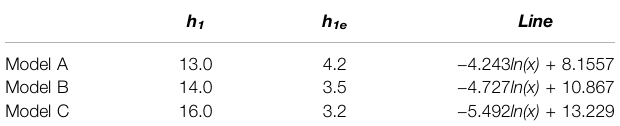
TABLE 2 | Valve lea fl ets model structure size parameters